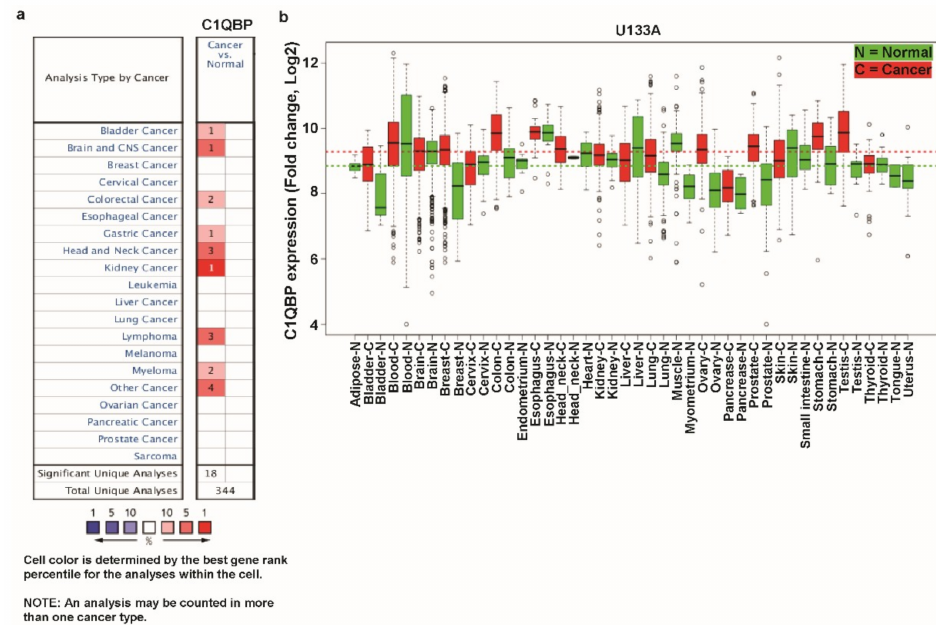
Figure 1. Transcription levels of C1QBP (Complement Component 1 Q Subcomponent-Binding